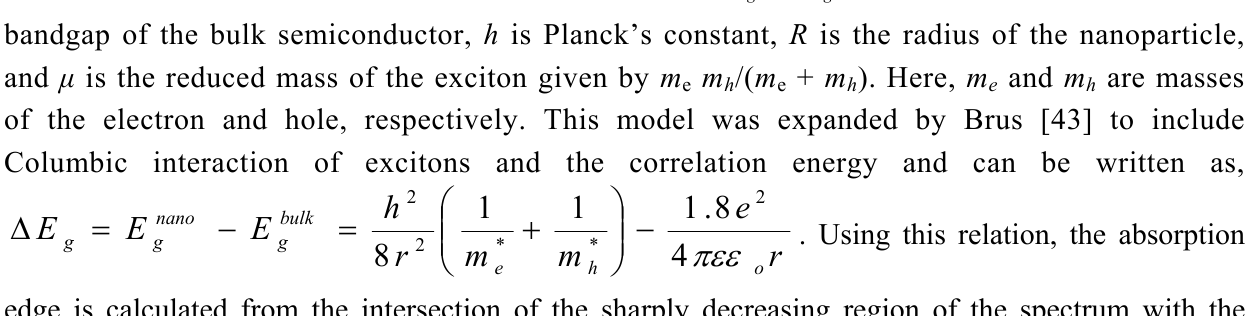
Figure 4. Absorption and emission spectra of the nanoparticles. ( A ) Absorption (a) and emission (b) spectra of ZnS nanoparticles; ( B ) Absorption (a) and emission (b) spectra of CdS nanoparticles; ( C ) Absorption (a) and emission (b) spectra of HgS nanoparticles.